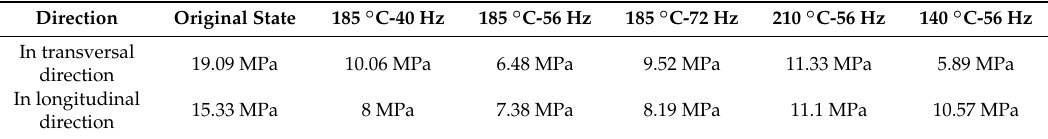
Table 5. Standard deviation of the average stress at four measuring points, before and after TVSR at different parameters. Unit: